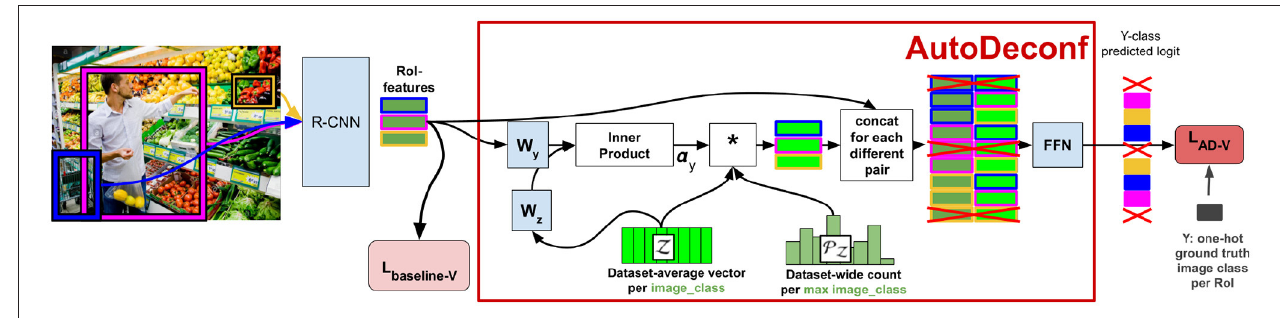
FIGURE 3 | Pipeline for